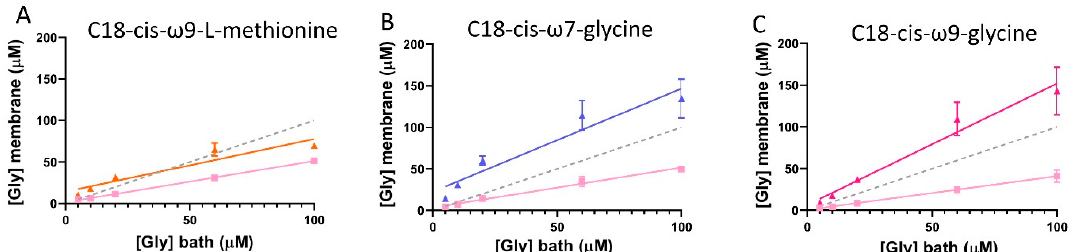
Figure 12. Glycine concentration sensed at the membrane of cells expressing GlyR α 1 / GlyT2 in the presence of GlyT2 specific inhibitors. Dashed line indicates reference 1:1 relationship of [Gly] bath and [Gly] membrane . Since currents are reduced under fast-flow conditions, the glycine concentration at the membrane under fast-flow conditions in co-expressed cells was estimated by substituting EC 50 and Hill co-e ffi cient values from cells expressing only GlyR α 1 , and current values from GlyR α 1 / GlyT2 co-expressed cells into the Hill equation (pink lines). Similarly, the glycine concentration at the membrane under fast-flow conditions in co-expressed cells and in the presence of ( A ) the GlyT2 inhibitor, C18- cis - ω 9-L-methionine (orange), ( B ) the GlyR PAM, C18- cis - ω 7-glycine (purple) and ( C ) the dual action modulator C18- cis - ω 9-glycine (magenta) was estimated by substituting EC 50 and Hill co-e ffi cient values from cells expressing GlyR α 1 / GlyT2, and current values from GlyR α 1 / GlyT2 + lipid into the Hill equation. Curves for GlyR α 1 / GlyT2 and GlyR α 1 / GlyT2 + lipid were fit by linear regression and values represent mean ± SEM, n ≥ 5.